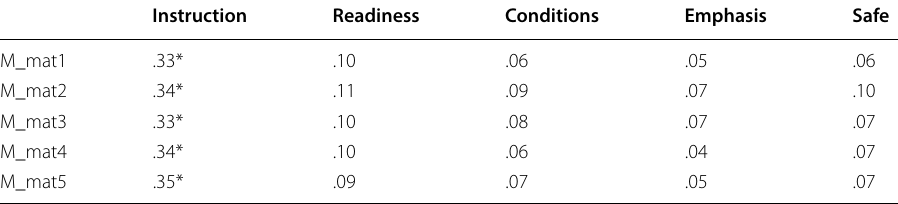
*Indicates the coefficients are significant at the alpha level of